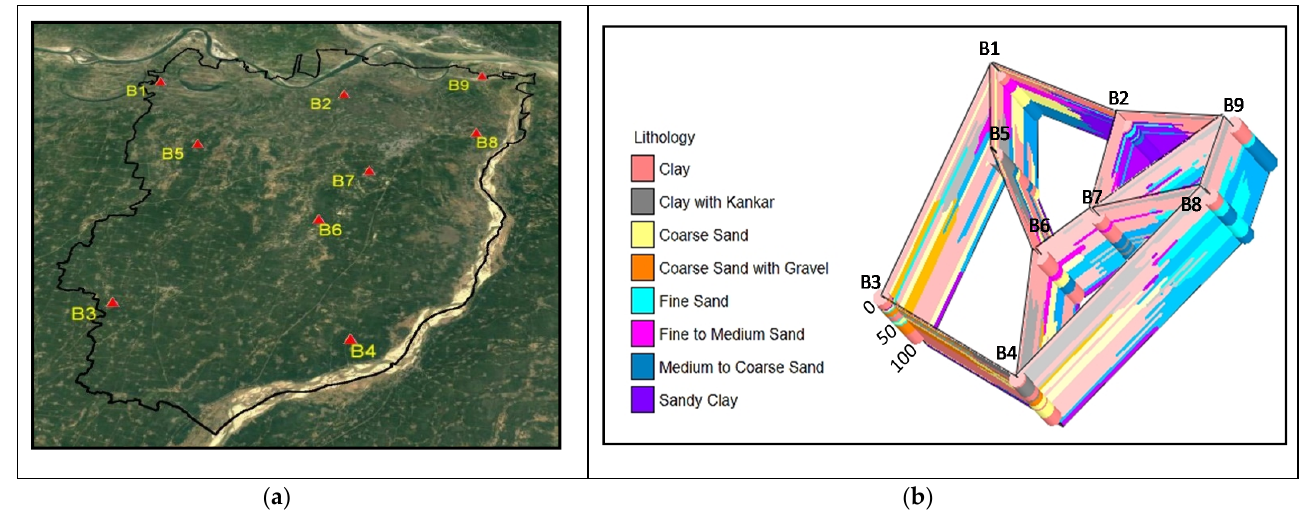
Figure 3. ( a ) Borelogs location in the study area; ( b ) fence diagram representing geological settings. The groundwater level data analyses (data collected from Central Ground Water Board (CGWB)) shows variation of groundwater level across the study area. The deepest groundwater level was observed in the north and northeast part of the study area. The unconfined aquifer has an average groundwater level ranging from 3 m bgl to 9 m bgl (data collected in pre-monsoon season, May 2017); the hydraulic gradients is about 0.0005 and groundwater flow directions are north and northeast (Figure 4) towards the river Ganga. In the pre-monsoon season, groundwater feeds into the Ganga river.